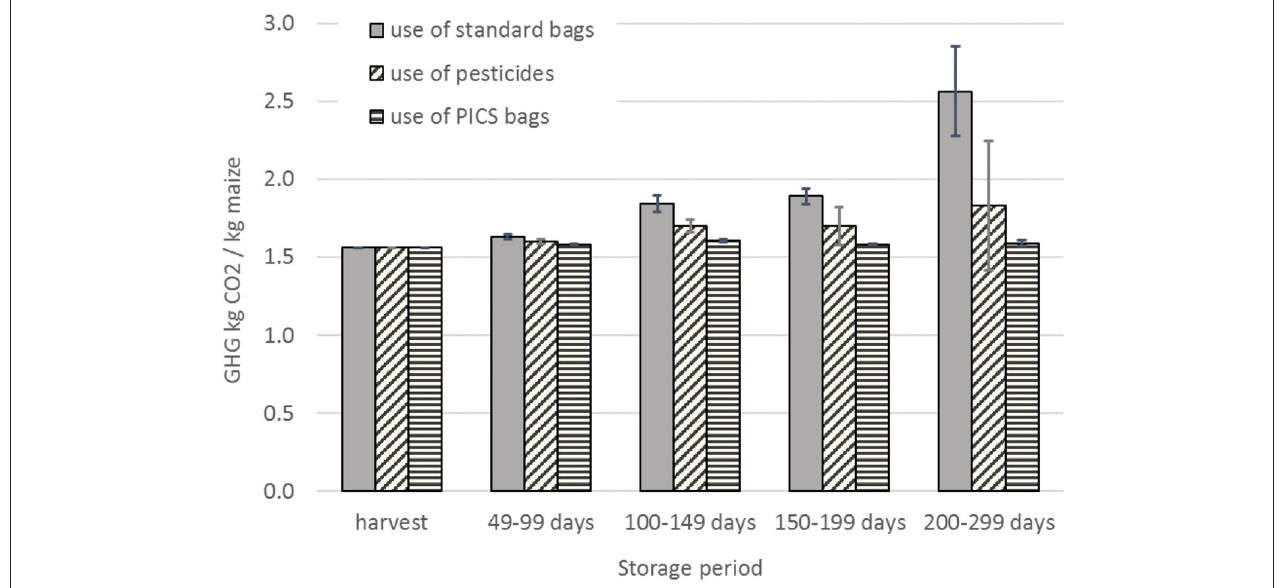
FIGURE 3 | Specification of calculated GHG emissions along the supply chain for the scenarios over time (kg CO 2 -eq. emissions per kg maize remaining for consumption). Error bars represent 95% confidence limits.